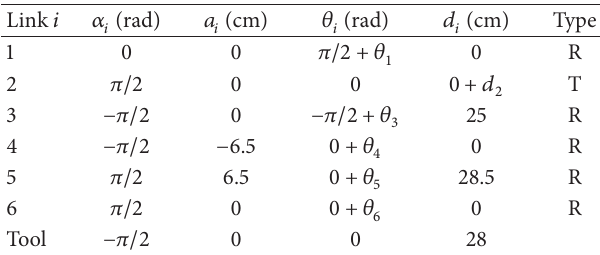
Table 2: D-H parameters of the generalized